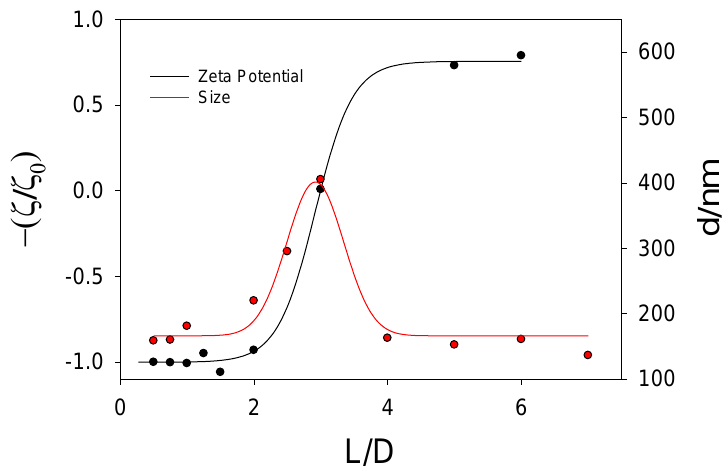
Figure 5. Plot of Z potential values (and size values) for lipoplexes containing RuC11C11 versus the parameter L / D at α = 0.5.